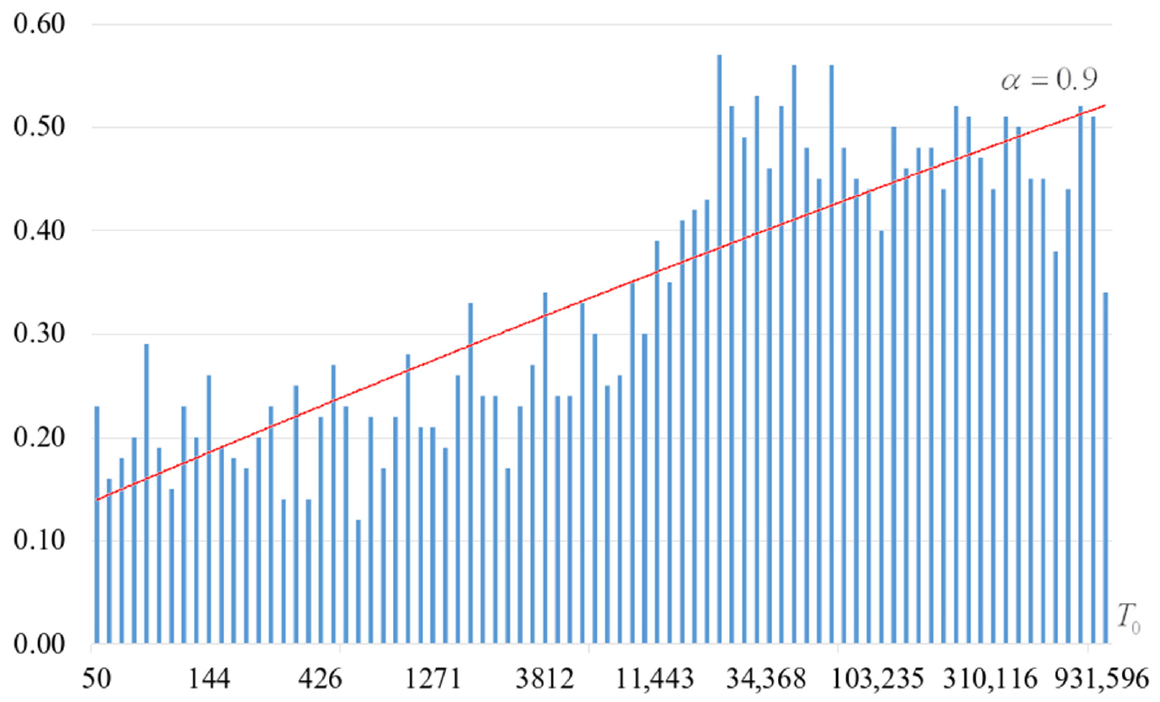
Figure 4. The probability of forming the target S-box at α = 0.8.